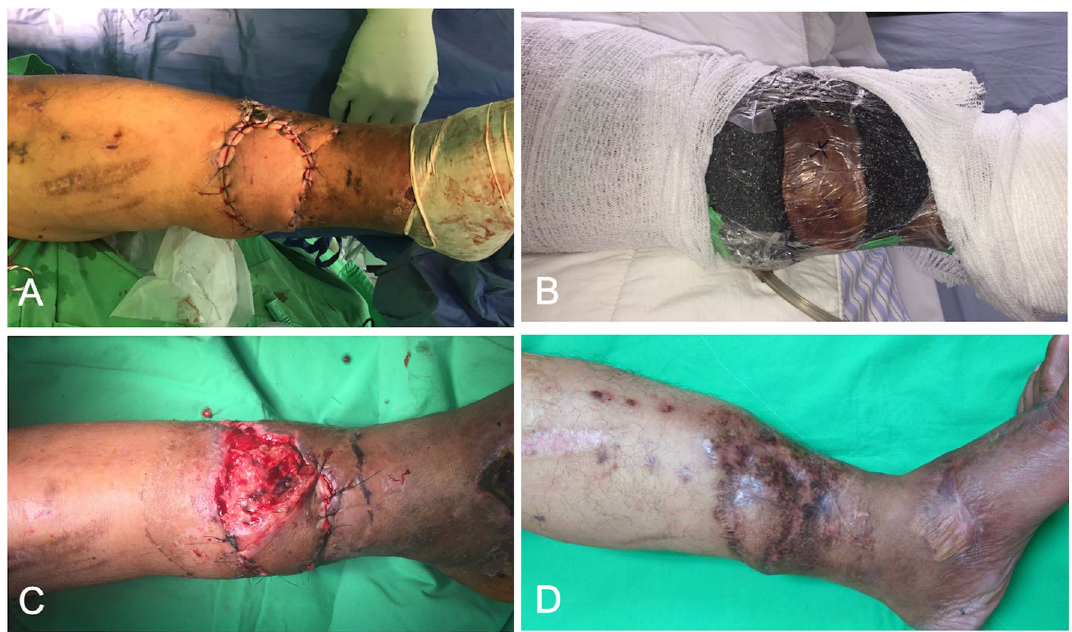
Figure 2. ( A ) A 40-year-old man with a smoking history underwent a reverse sural flap for his left lower leg with osteomyelitis and soft-tissue defects. ( B ) Venous congestion was noted on postoperative day 1, then NPWT was discontinued. ( C ) Partial loss of the distal part of the flaps was subsequently treated with debridement and skin grafting. ( D ) After one year, the wound has completely